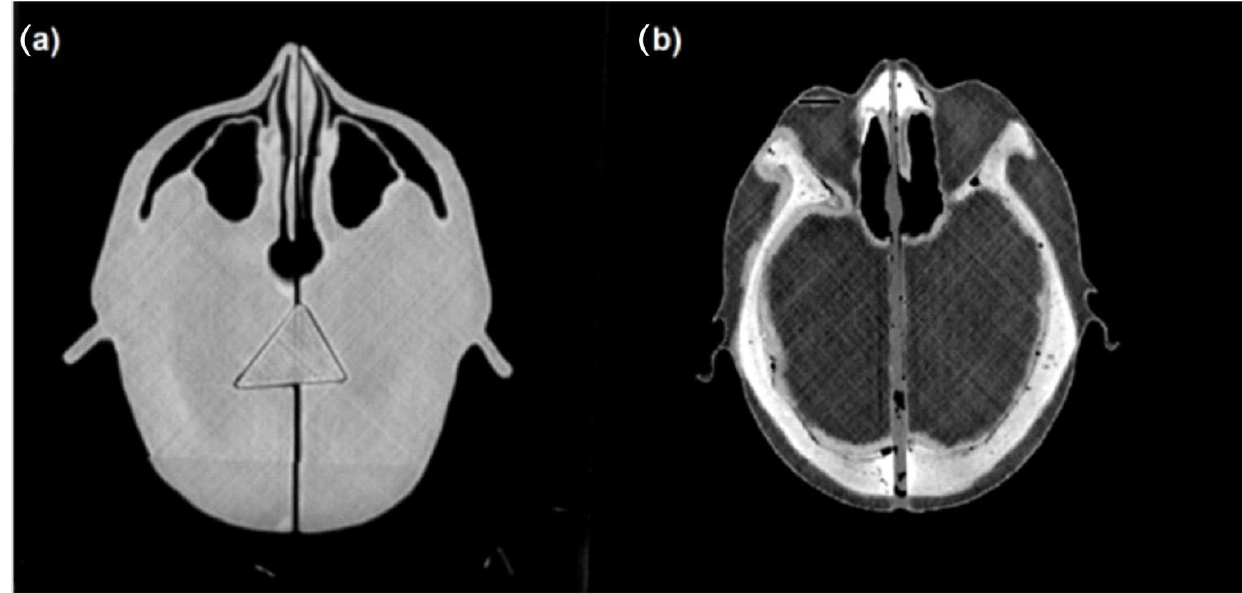
Figure 1. CT images of the phantom before ( a ) and after ( b ) filling of the bone spaces with plaster.